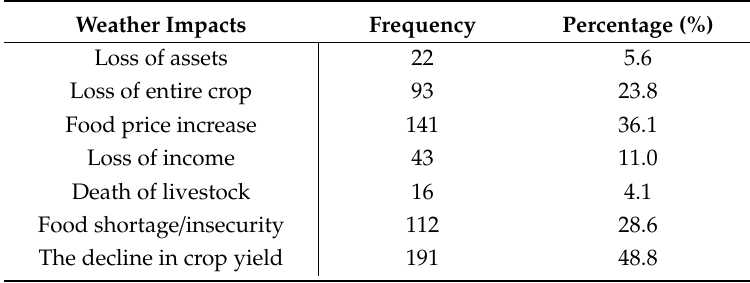
Table 3. Farmers’ perception of the e ff ects of climate change ( n = 391).